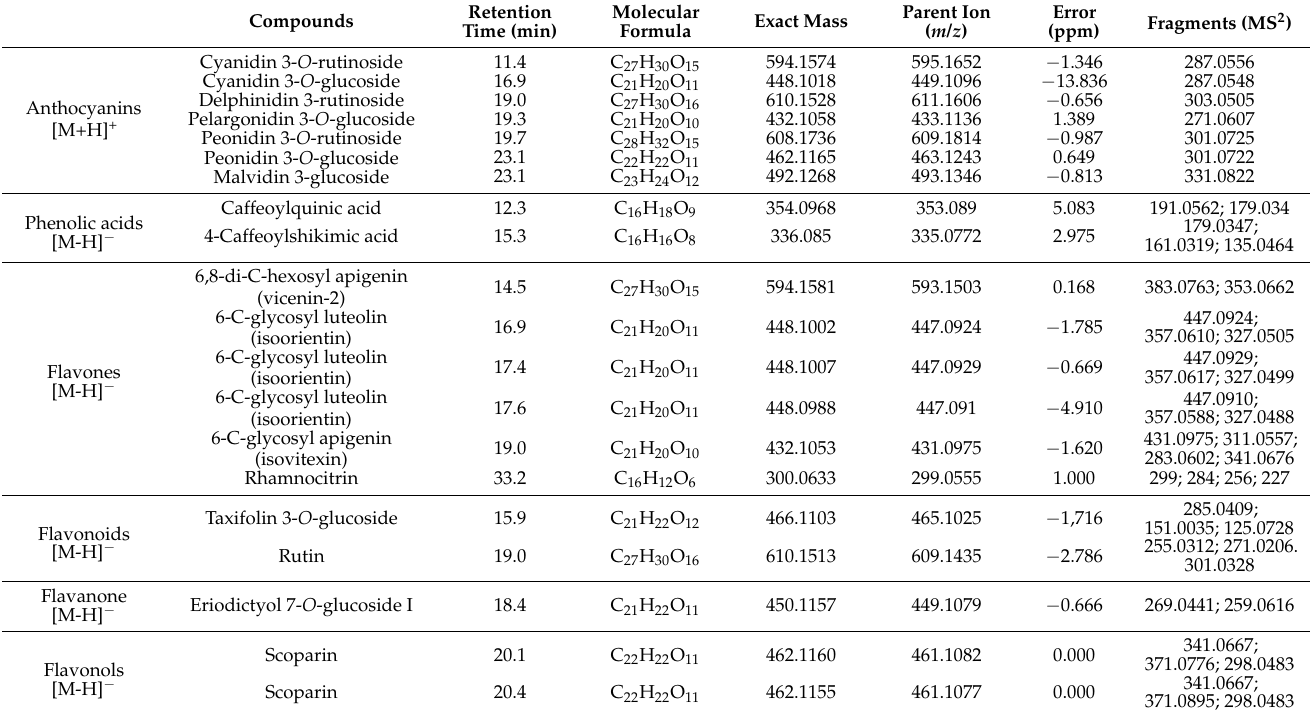
Table 1. Phenolic compounds tentatively identified in the optimized aça í meal extract by LC-ESI-